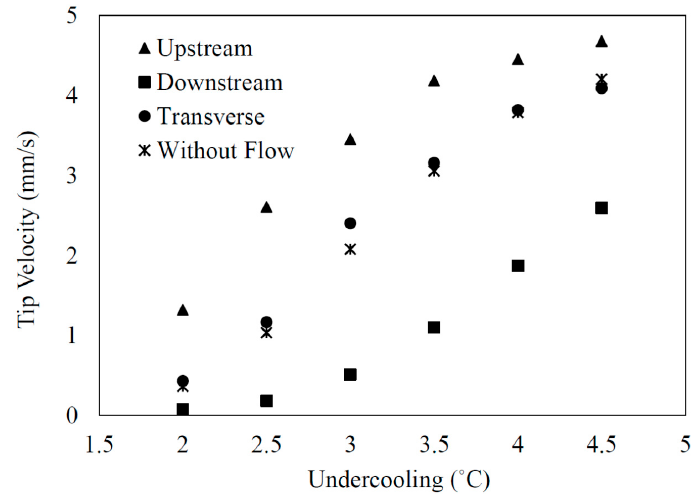
Figure 10. Variation of average tip growth velocity with undercooling for upstream, downstream, and transverse branches of a dendrite growing under the inlet velocity of U 0 = 7 mm/s and for the case without melt convection.